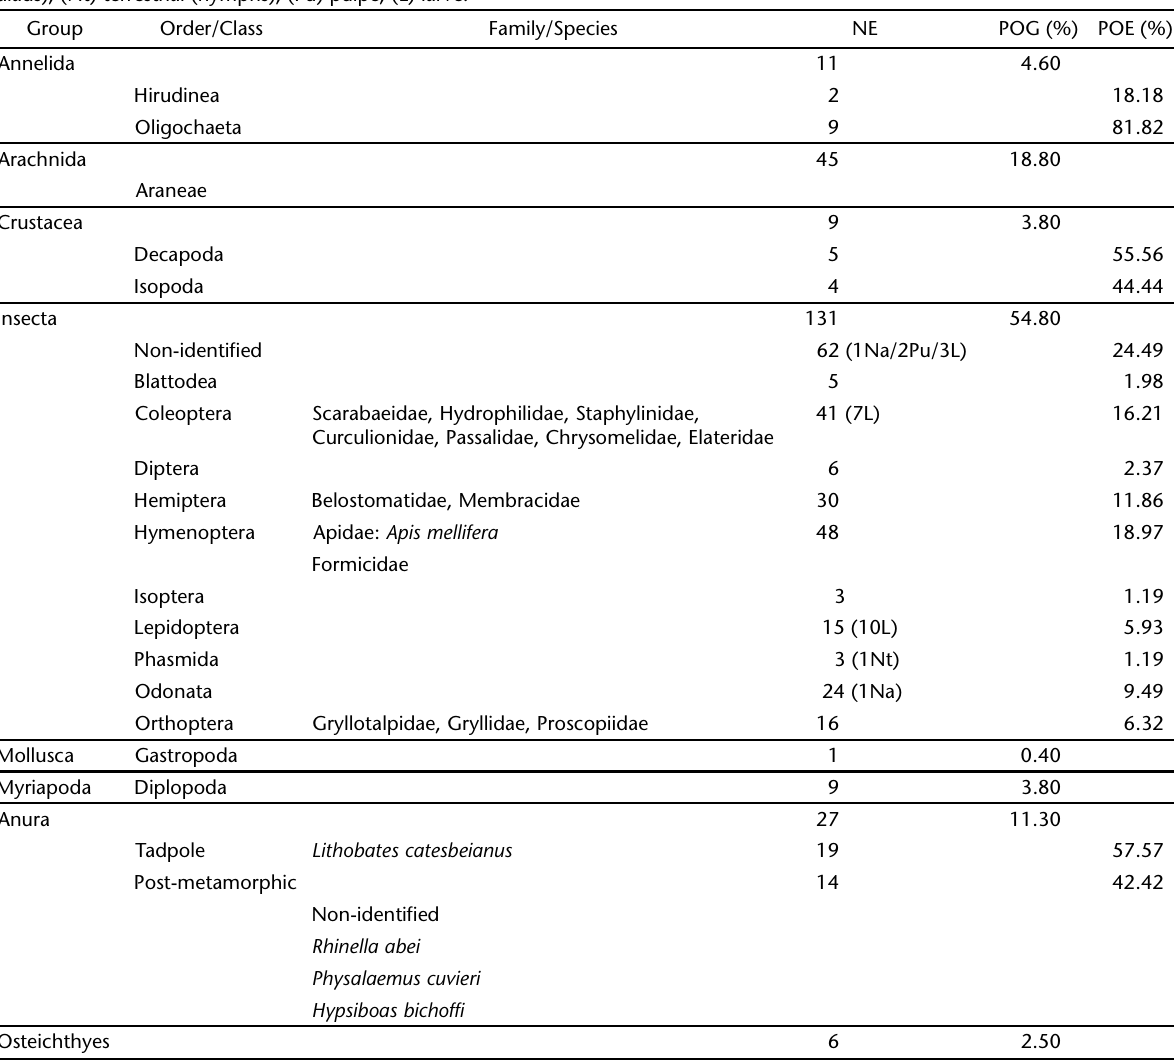
Table I. Prey items found in the diet of L. catesbeianus in the municipalities of Campina Grande do Sul, Quatro Barras and Bocaiúva do Sul, State of Paraná, Brazil. Group corresponds to large groups in the diet; Order/Class and Family/Species corresponds to a more refined identification of the items within each group; (NE) number of stomachs in which each item occurred; (POG) percentage of occurrence of the large groups in the diet; (POE) percentage of occurrence of classes or orders in each larger group. Imature insects: (Na) aquatic (naiads), (Nt) terrestrial (nymphs), (Pu) pulpe, (L)